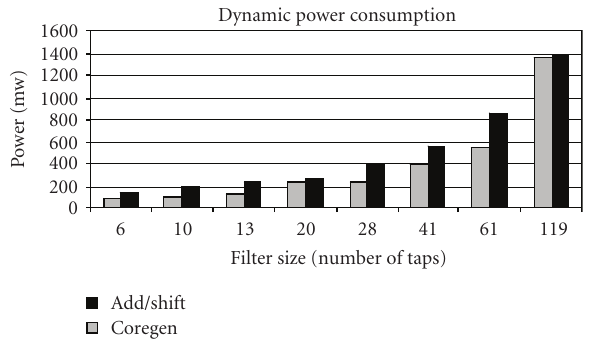
Figure 12: Comparison of power consumption for add and shift (this paper) relative to that for the DA showing up to 50% reduction in dynamic power